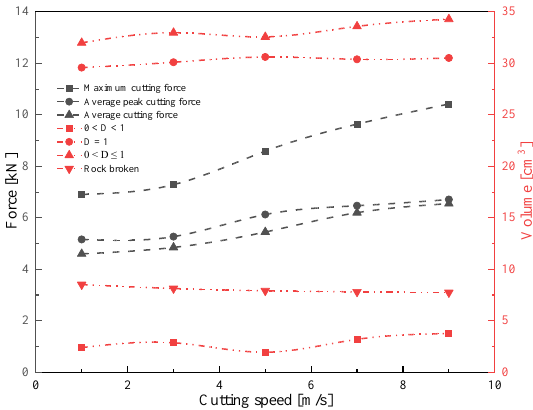
Figure 21. The forces and volumes of damaged and broken rock with various distances between